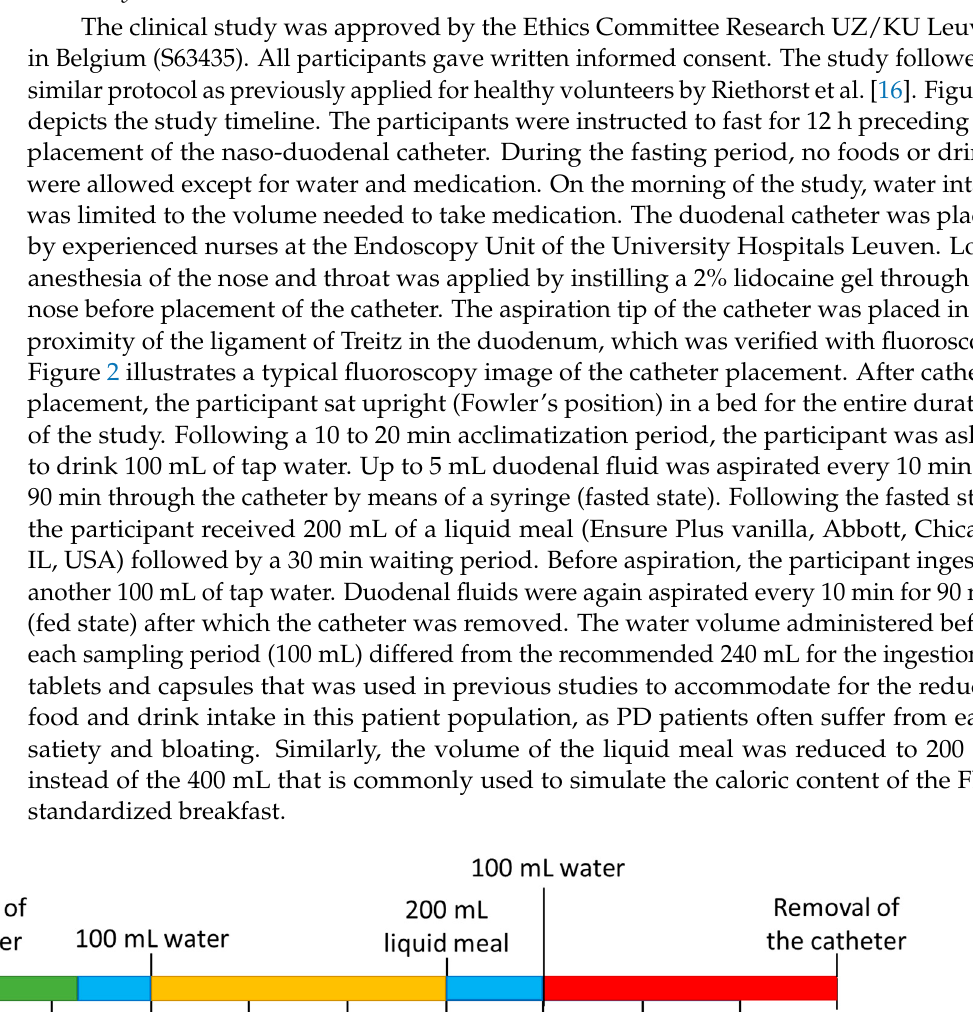
Figure 2. Typical fluoroscopy image with placement of the aspiration tip (red arrow) of the duode- nal catheter near the ligament of Treitz. The catheter is indicated by the blue dotted line. The yellow dotted arrow indicates the transition from stomach to duodenum. At each sampling timepoint, the aspirated fluid was aliquoted for the determination of different compositional factors (i.e., pH (100 µL), buffer capacity (400 µL), osmolality (300 µL), bile salts (50 µL), phospholipids (50 µL), total protein (20 µL) and lipid digestion products and cholesterol (200 µL)). The pH and buffer capacity were measured instanta- neously, and the remaining aliquots were frozen on dry ice during the remainder of the study and stored at − 20 °C afterwards while awaiting further analysis. To minimize ex vivo lipid digestion, lipase activity in the aliquots for determination of lipids and phos- pholipids was inhibited by adding a 1 mM orlistat stock solution in methanol (final con- centration 1 µM). Whenever insufficient intestinal fluid could be aspirated for a full anal- ysis, characteristics were prioritized as follows (considering relevance for drug absorption and required volume for analysis): pH > bile salts > lipid digestion products and choles- terol > phospholipids > total protein > osmolality > buffer capacity.